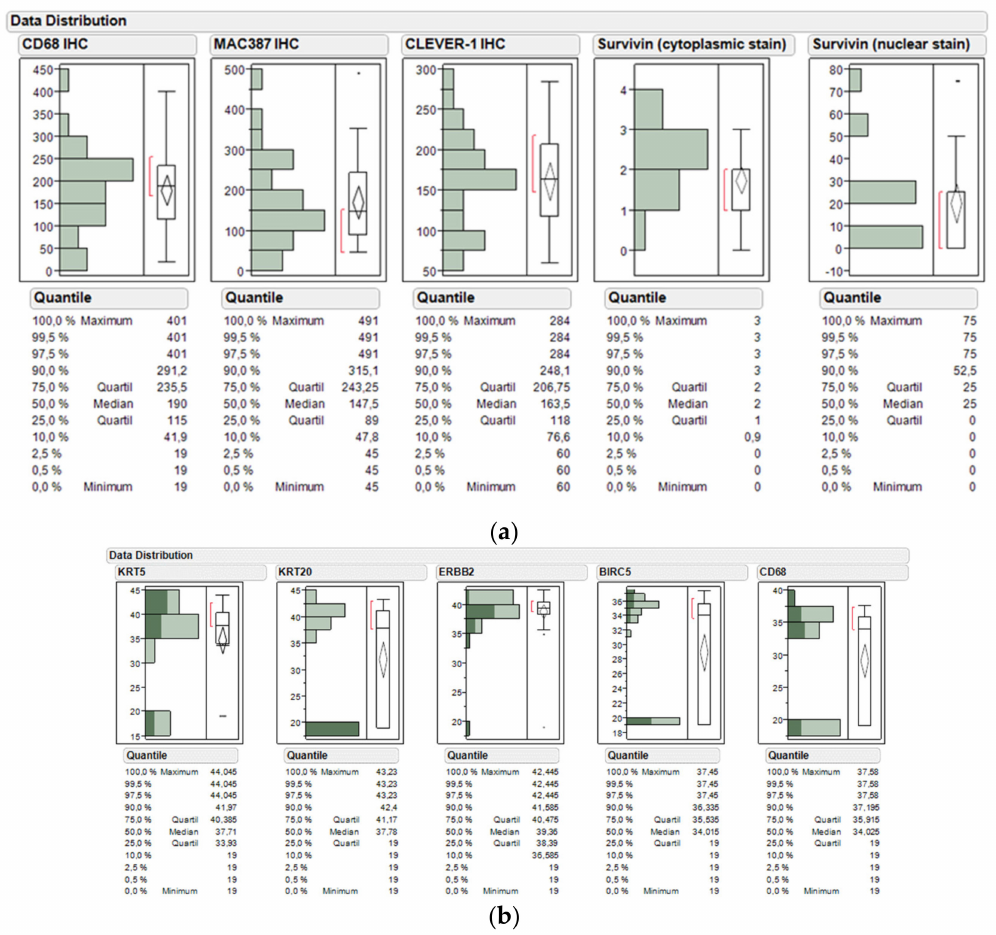
Figure 2. ( a ) Data distribution of immunohistochemical staining of CD68, MAC387, and common lymphatic endothelial and vascular endothelial receptor-1 (CLEVER-1) by visual analysis and survivin by semi-quantitative assessment of cytoplasmic versus nuclear stain; ( b ) Data distribution and box and whisker plot of KRT5 , KRT20 , ERBB2 , BIRC5 , and CD68 mRNA levels in the bladder cancer study cohort treated by adjuvant chemotherapy ( n = 39). Normalized gene expression (40-DCT method) as well as quantile values are depicted in the y-axis. DCT: Delta Cycle